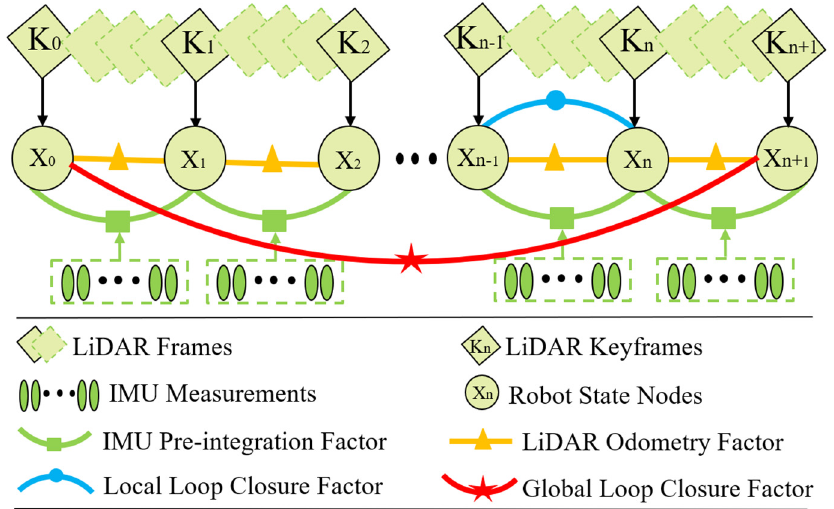
Figure 5. Schematic diagram of factor graph optimization by the proposed method.